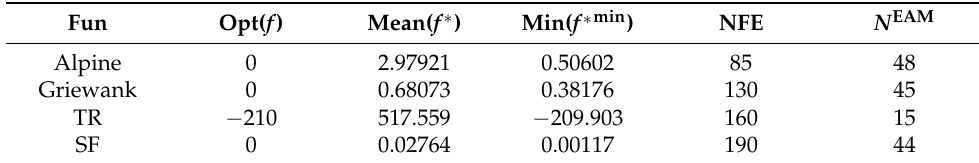
Table 2. The results on four functions.